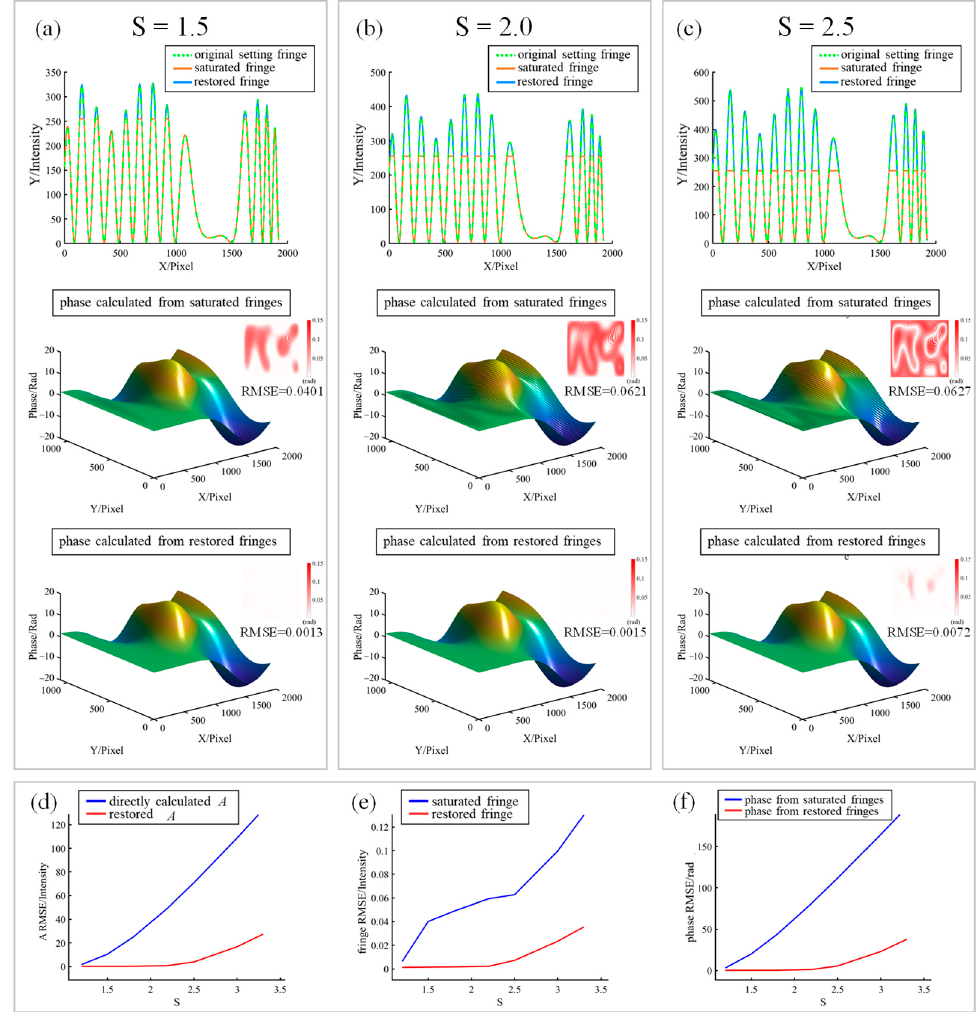
Figure 6. Simulation verification of the proposed method. Panels ( a – c ) are the cases when S = 1.5, 2.0, 2.5, respectively. The first row is the comparison of the section lines of the original setting fringe, saturated fringe, and restored fringe. The second row is the comparison of the spectra of the original, saturated, and restored cases. The third row is the phase calculated directly from the saturated fringes, and the fourth row is the phase calculated using the restored fringes. The small figures at the upper right corners of the second and third rows indicate the error maps. ( d ) Error comparison between the directly calculated A and restored A changing with S . ( e ) Error com- parison between the saturated fringe and restored fringe changing with S . ( f ) Error comparison between the phases obtained directly from the saturated fringes and those from restored fringes changing with S .